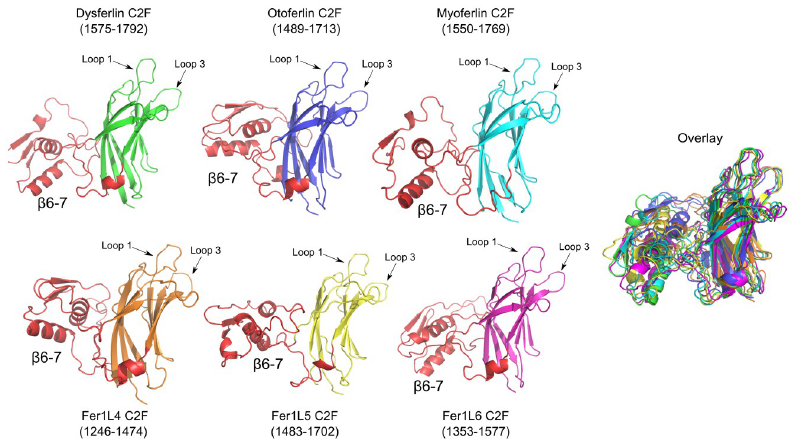
Fig 11. Dysferlin C2F (green), otoferlin C2F (blue), myoferlin C2F (cyan), Fer1L4 C2F (orange), Fer1L5 C2F (yellow), Fer1L6 (magenta). The β 6–7 subdomain of C2F is labeled and colored red. The overlay of each domain is to the right of the figure.